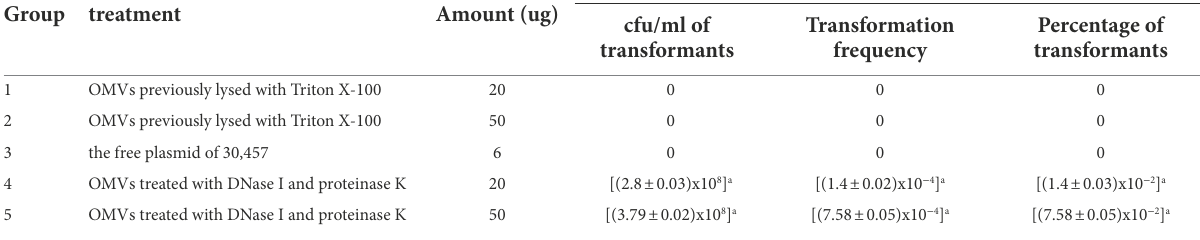
TABLE 3 Different treatments of vesicle-mediated transformation. Group treatment